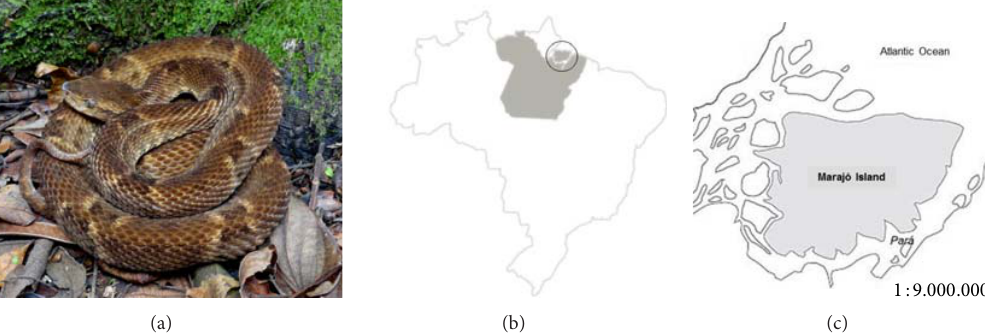
Figure 1: (a) Image of an adult male specimen of Bothrops marajoensis (photo: Silvia Cardoso, Ph.D.; Museu Biol´ogico/Instituto Butantan, S˜ao Paulo, SP, Brazil). (b) The Brazilian map with Par´a state in gray and (c) an enlarged detail of the Maraj´o Island and costal drainage at the Amazon